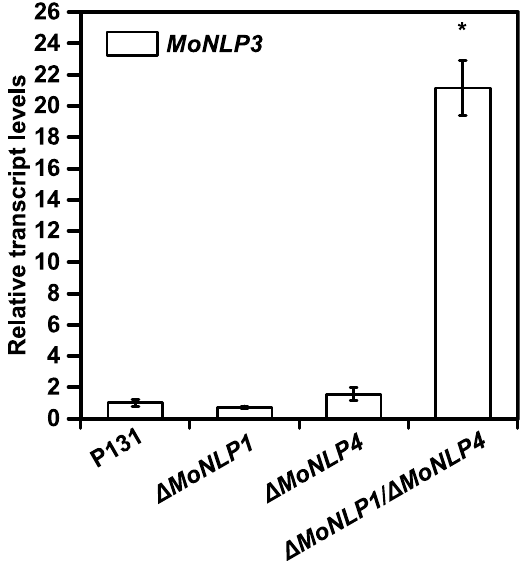
Figure 5. The expression of MoNLP3 is significantly enhanced in Δ MoNLP1/ Δ MoNLP4 mutant during infection of rice. Leaves of 10-day-old rice seedlings were inoculated with wild type and mutants of M. oryzae , and samples were harvested at 96 hpi. Transcript levels of MoNLP3 were determined by real-time PCR using Actin as the reference gene. Data shown are means ± sd of three replicates. Asterisk indicates a significant difference from P131 (Student’s t test, P < 0.05). The experiment was repeated at least twice with similar